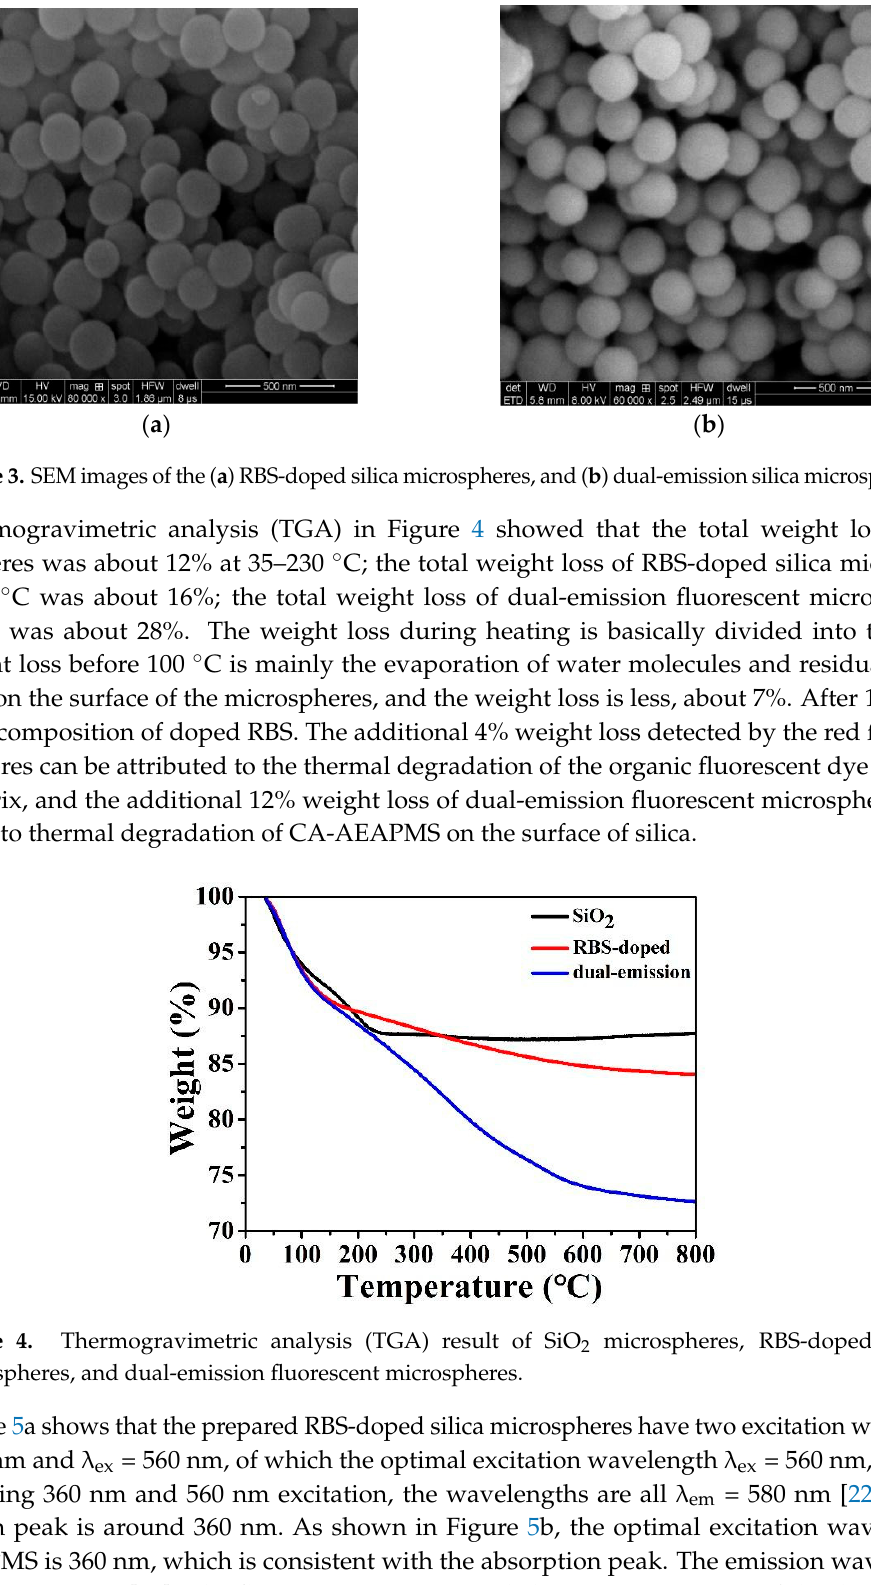
Figure 4. Thermogravimetric analysis (TGA) result of SiO 2 microspheres, RBS-doped silica microspheres, and dual-emission fluorescent